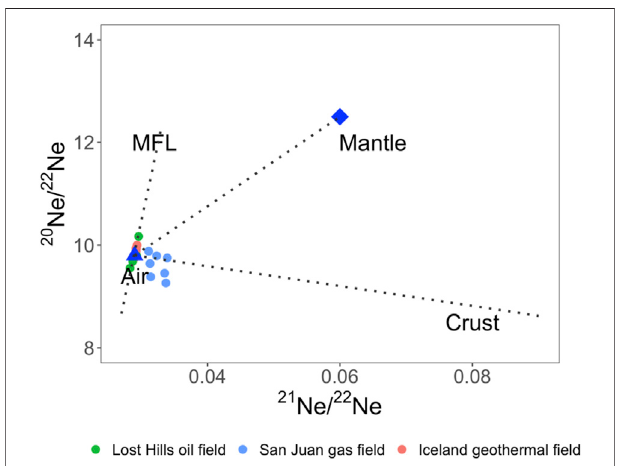
FIGURE 2 | Neon three-isotope plot for selected noble gas studies in different subsurface systems. MFL represents a mass-dependent fractionation line, which is used for constraining mass-fractionation-related processes. Data sources: Lost Hills oil fi eld(Barry et al., 2018), San Juan gas fi eld (Zhou et al., 2005), and Iceland geothermal fi eld (Byrne et al., 2021).